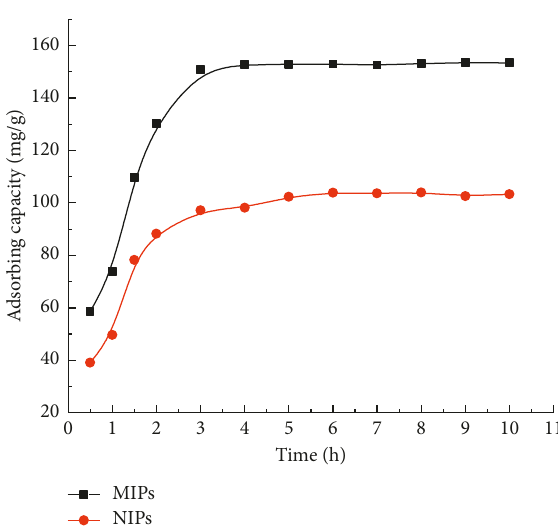
Figure 8: Dynamic adsorptions of MIPs and